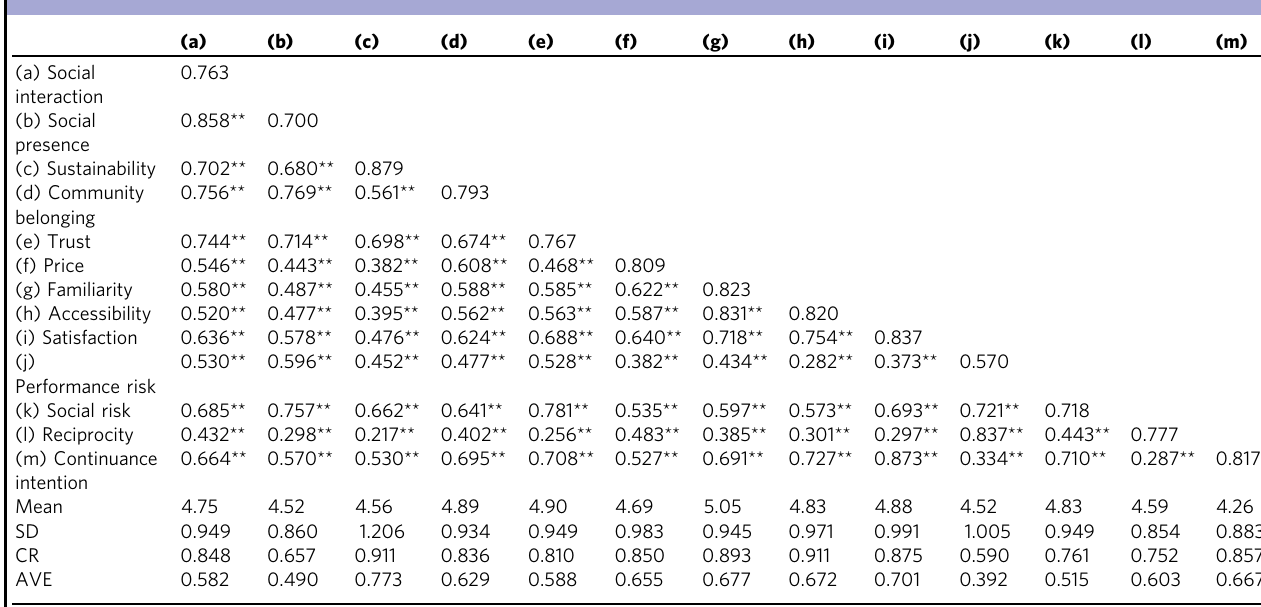
Table 1 The measurement model evaluation